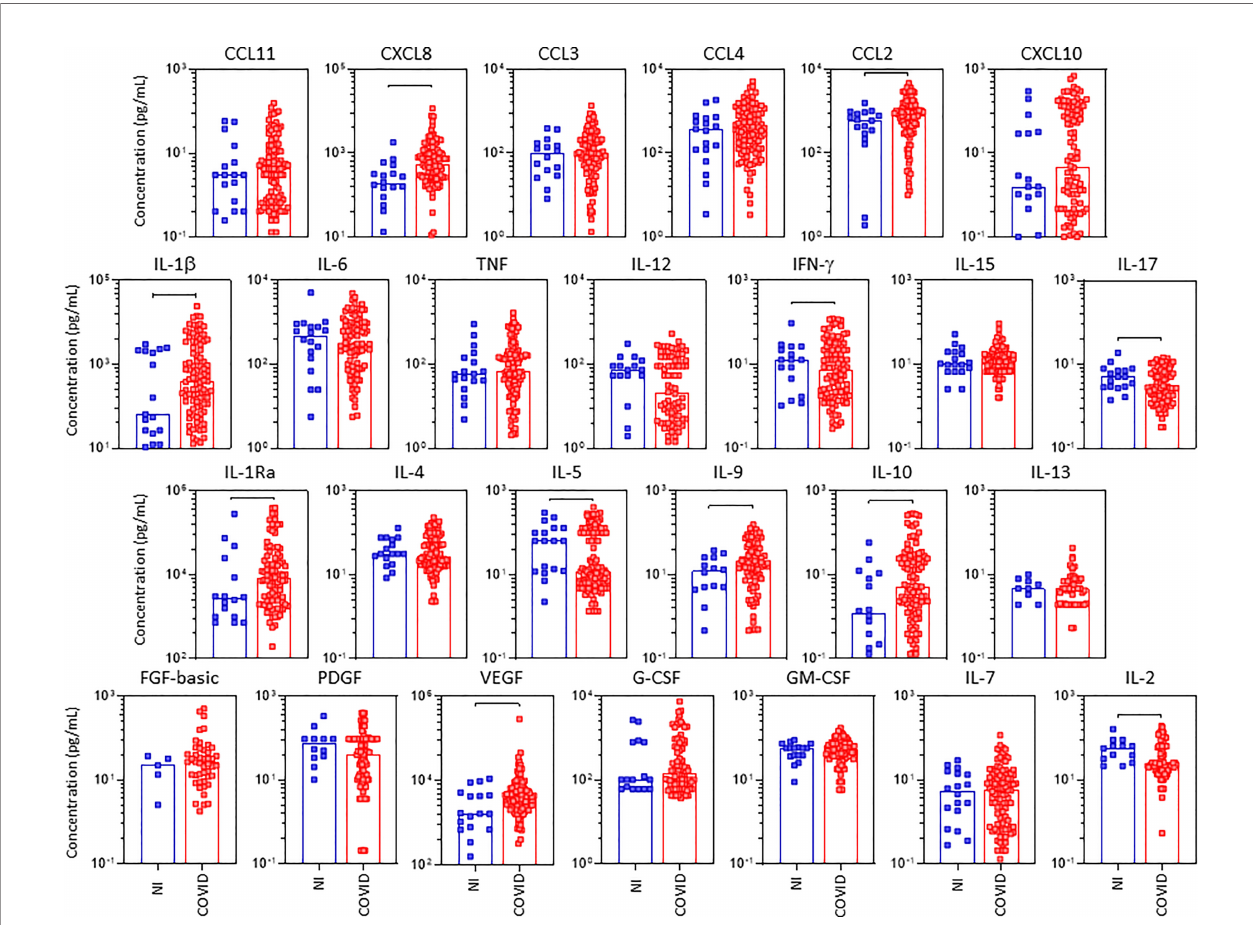
FIGURE 5 | Landscape of airway soluble immune mediators in tracheal aspirate samples from critically ill COVID-19 patients at ICU admission. The concentration of chemokines (CXCL8, CCL11, CCL3, CCL4, CCL2, CXCL10), pro-in fl ammatory cytokines (IL-1 b , IL-6, TNF, IL-12, IFN- g , IL-15, IL-17), regulatory cytokines (IL-1Ra, IL-4, IL-5, IL-9, IL-10, IL-13) and growth factors (FGF-basic, PDGF, VEGF, G-CSF, GM-CSF, IL-7 and IL-2) were quanti fi ed in tracheal aspirate samples from critically ill COVID-19 patients – “ COVID ” ( ■ , n = 103) at ICU admission (D0 = baseline), as compared to non-infected patients – “ NI ” ( ■ , n = 18). Measurements were carried by high-throughput microbeads array as described in Material and Methods section. The results are expressed in pg/mL and presented as scattering distribution of individual values over bar plots underscoring the median value on each bar. Signi fi cant differences at p < 0.05 are indicated by connecting